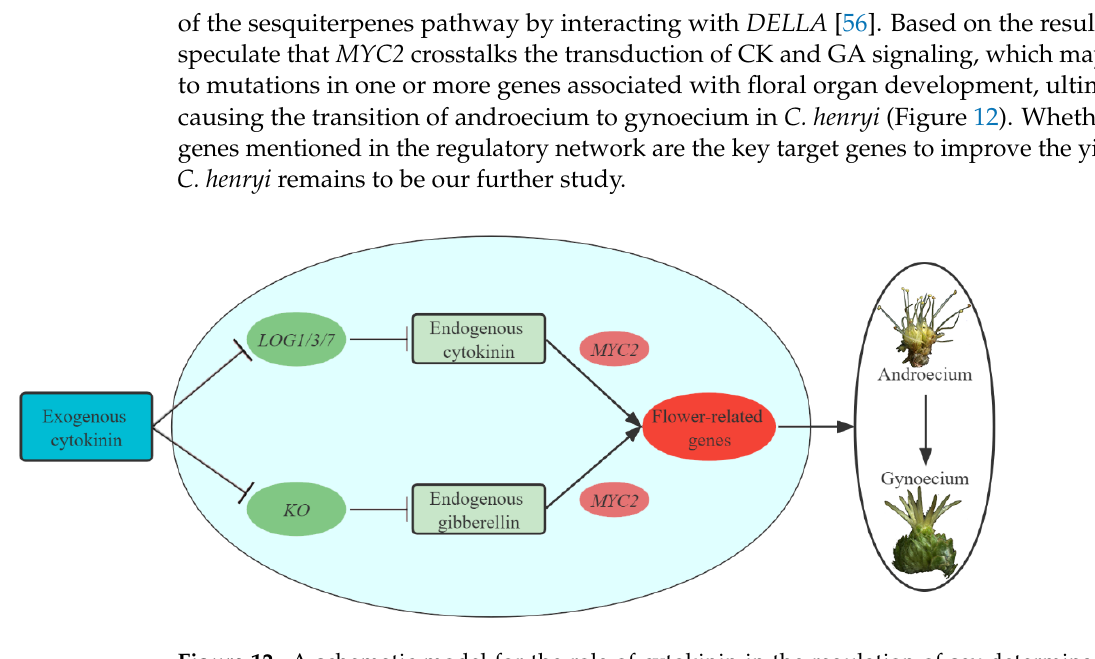
Table 5. Different treatment methods.